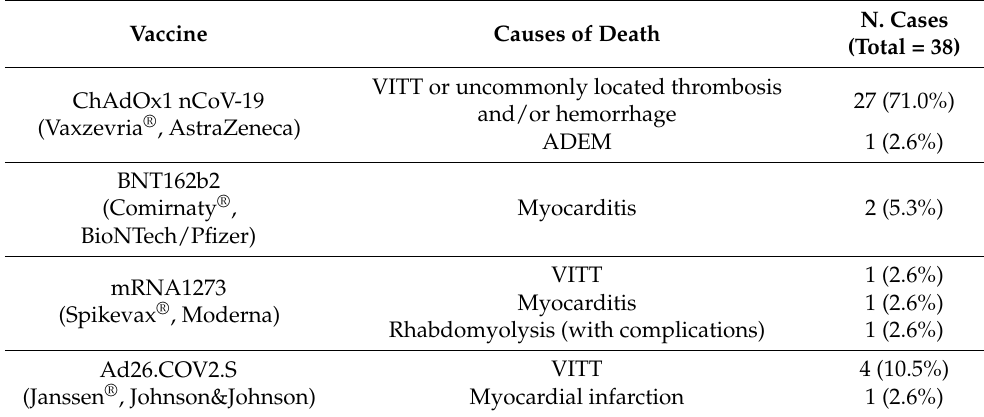
Table 2. The distribution of causes of death per type of vaccine. The cases in which the causal relationship between the vaccine and the death was not demonstrated or improbable have not been included in this table, so the total number of cases that have been considered is 38. ADEM